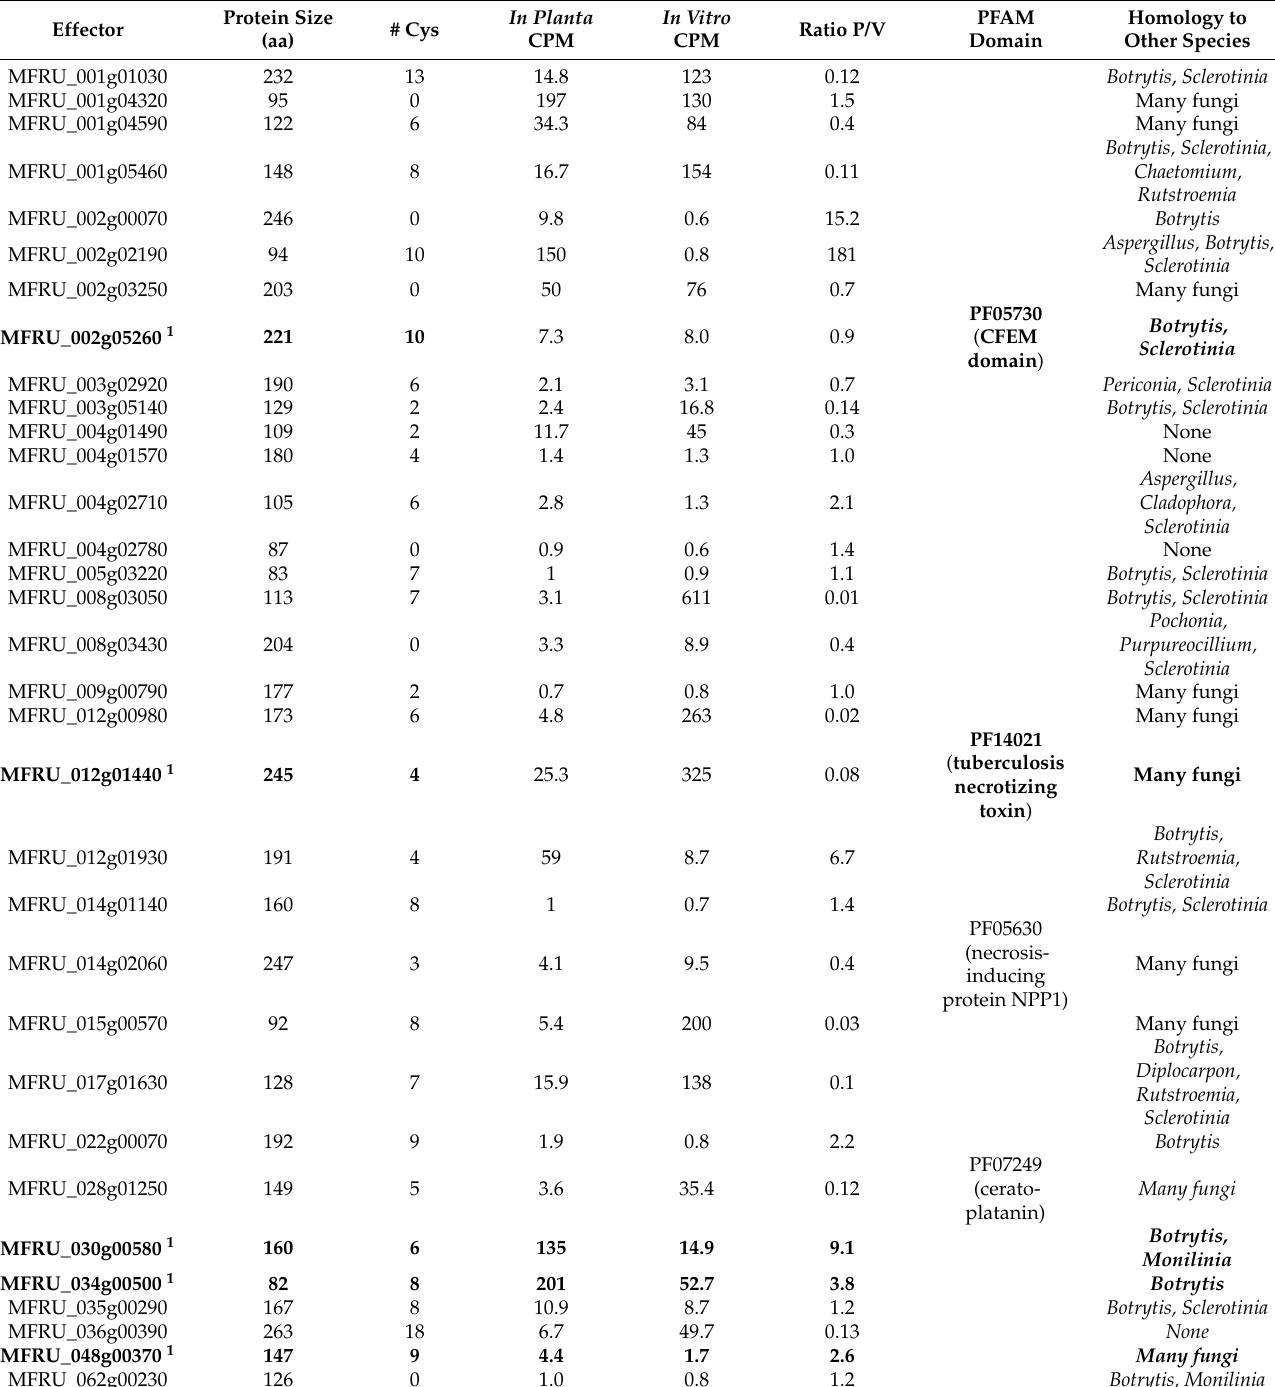
Table 3. Annotations of candidate effectors and their expression in vitro and in infected plant